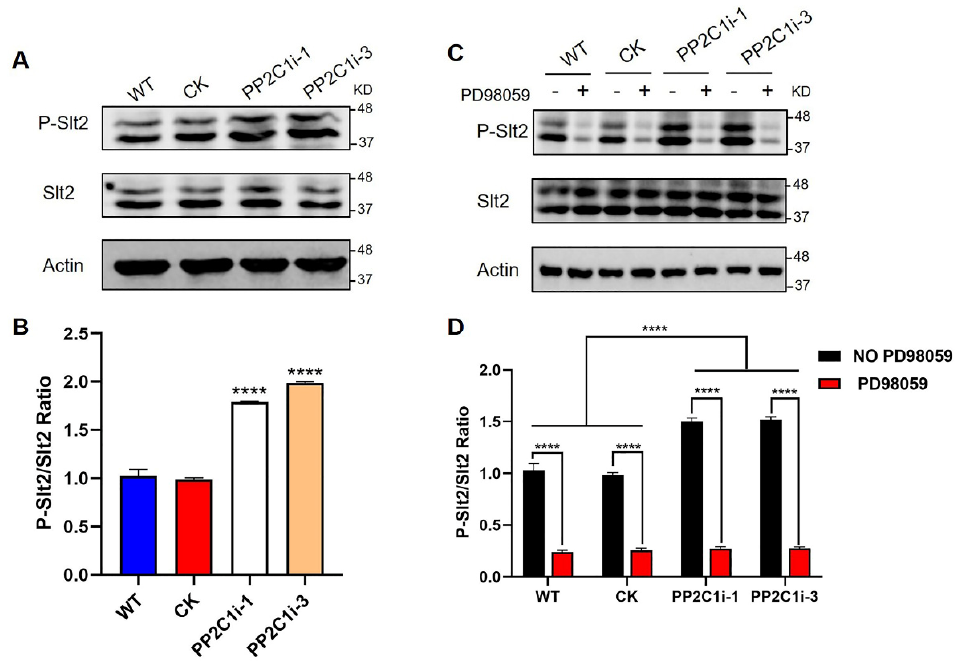
Figure 4. PP2C dephosphorylation of Slt2 in vivo. ( A ) The phosphorylation level of Slt2 in WT, CK and PP2C-silenced strains was detected with anti-pERK and anti-ERK antibodies. ( B ) P-Slt2/Slt2 ratio from panel A. ( C ) The phosphorylation level of Slt2 was detected with anti-pERK and anti-ERK antibodies after the addition of 20 µ M PD98059 to the WT, CK and PP2C-silenced strains. ( D ) P-Slt2/Slt2 ratio from panel C. The data are presented as the means ± SDs from three independent experiments (**** p < 0.0001 by one-way ANOVA or two-way ANOVA).